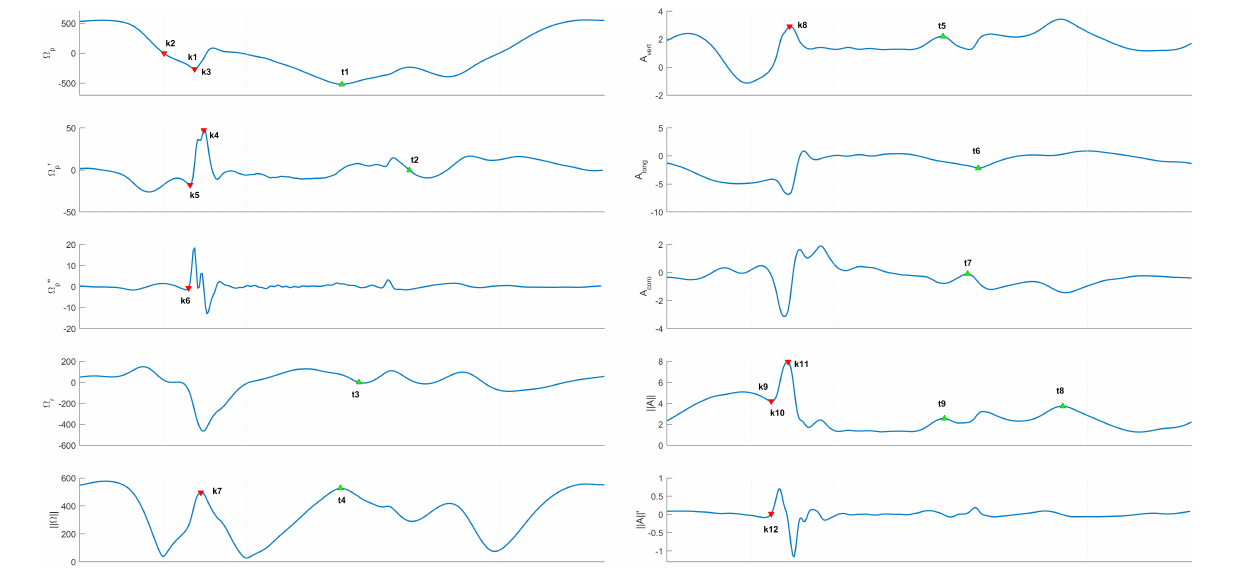
FIGURE 2 | Features used on the kinematic signals recorded by the foot-worn inertial sensors. IC candidates are identified by kj with j ∈ {1 ... 12} and TC candidates are identified by tj with j ∈ {1 ... 9}. The vertical gray dashed lines show the limits of the detection zones for IC and TC candidates. The signals showed in this figure belong to the same step and are represented during one mid-swing to mid-swing